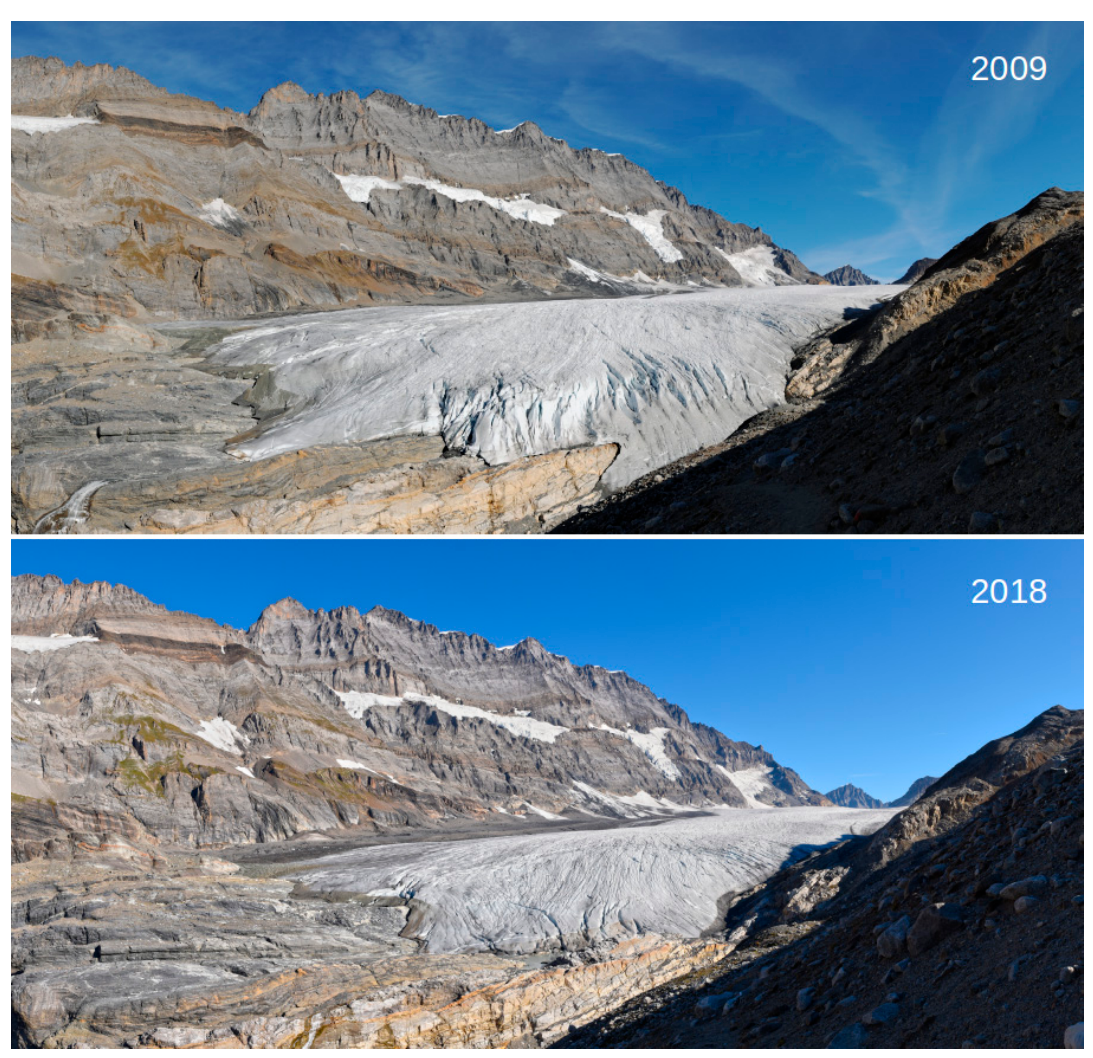
Figure A1. Downwasting of the Kanderfirn between 2009 and 2018 (photo credits: Simon Oberli). More comparative photographs of the Kanderfirn are available online (www.swissglaciers.org). Table A1. Individual components of the UAS (the stated costs are only rough estimates).